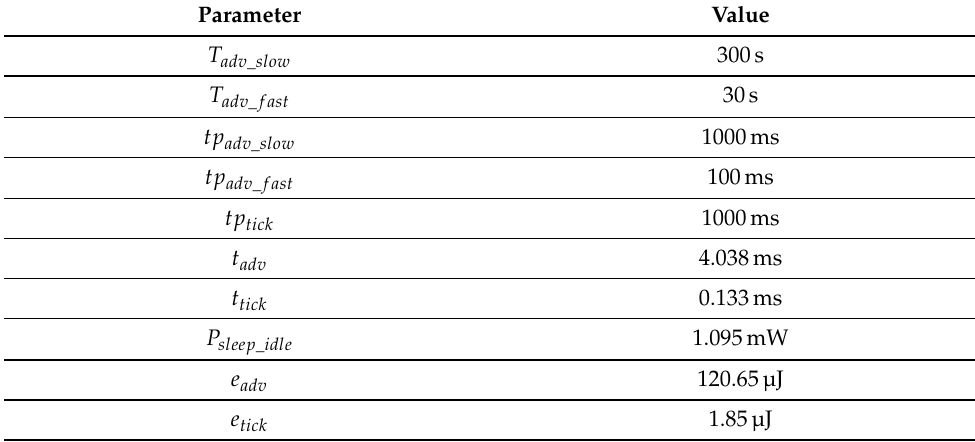
Table 2. BLE idle mode evaluation